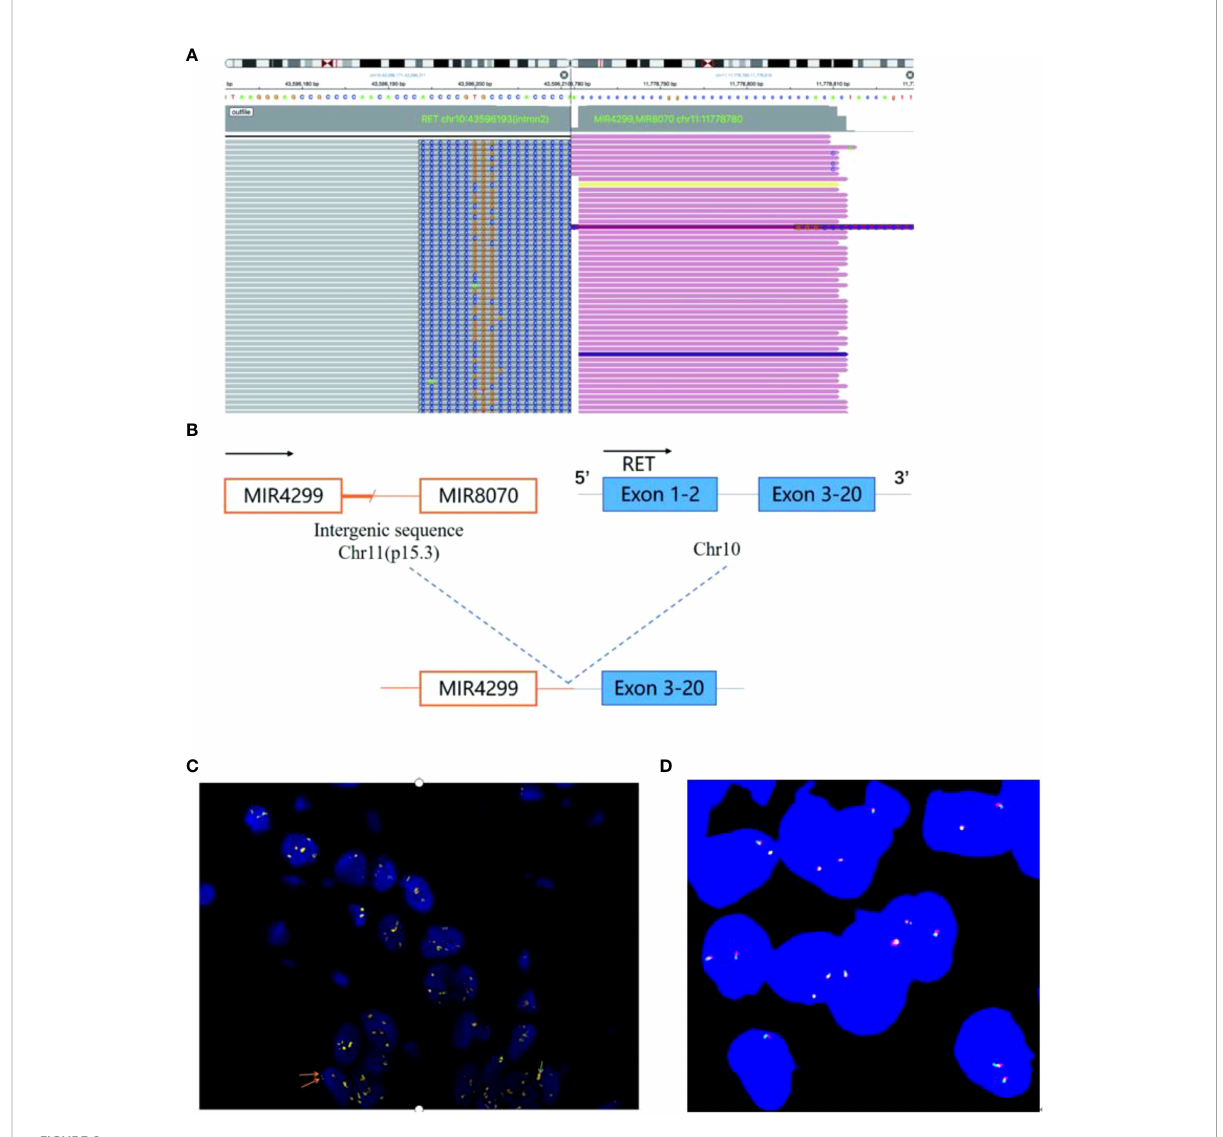
FIGURE 2 NGS and FISH fi ndings. (A) NGS analysis showing a breakpoint of the MIR4299/MIR8070-RET fusion and their sequence information. (B) Schematic diagram of the MIR4299/MIR8070-RET fusion. (C) FISH results showing the RET signal. FISH tests on lung biopsy tissue from the patient revealed more than 60% tumor content. FISH with RET dual color break-apart probe. The red signal represents the 5 ’ end RET gene while the green signal represents the 3 ’ end RET gene. The signal separated red and green signals, consistent with RET fusion. In most cases, the red signal and green signal were synchronized in clusters, and RET gene ampli fi cation could be con fi rmed by combining microscopic observation. Yellow represents red and green signals superimposed. In addition, the ampli fi ed signal (yellow signal, or clusters of red-green signal) is too strong, which obscures the